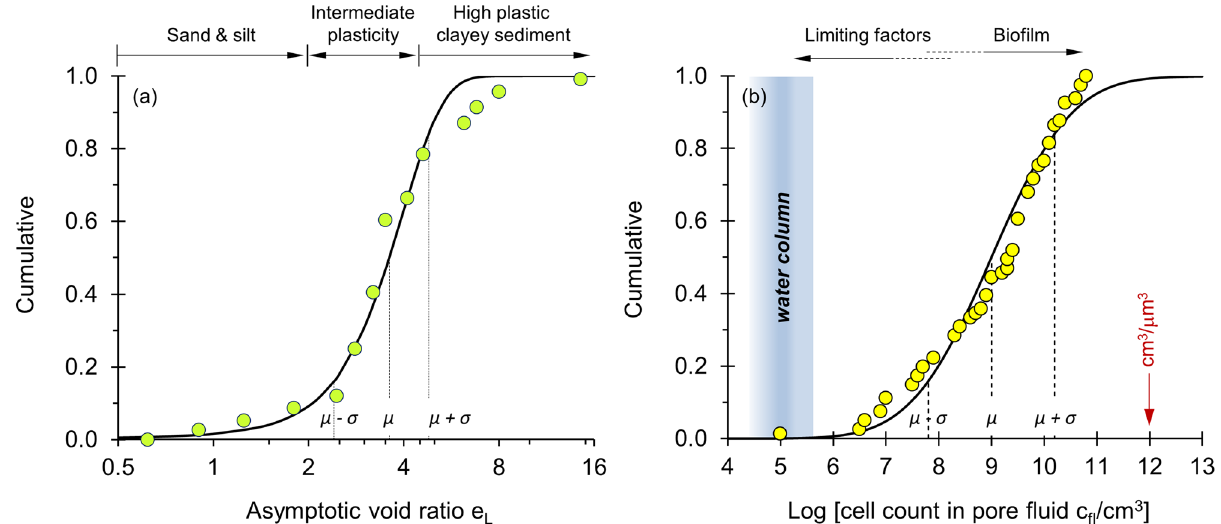
Figure 4. Cumulative distributions of the two key parameters fitted to the 116 depth profiles collected from ODP and IODP sites. The trend line is the Gaussian function. ( a ) Asymptotic void ratio e L (mean value µ = 3.6 and standard deviation σ = 1.2). The number of sediment profiles for different ranges of the asymptotic void ratio are: 11 for e L < 2, 81 for 2 < e L < 5, and 24 for e L > 5. ( b ) Cell concentration in the pore fluid c fl for intermediate plasticity sediments (N = 81 profiles—mean value µ = 9.0 and standard deviation σ =